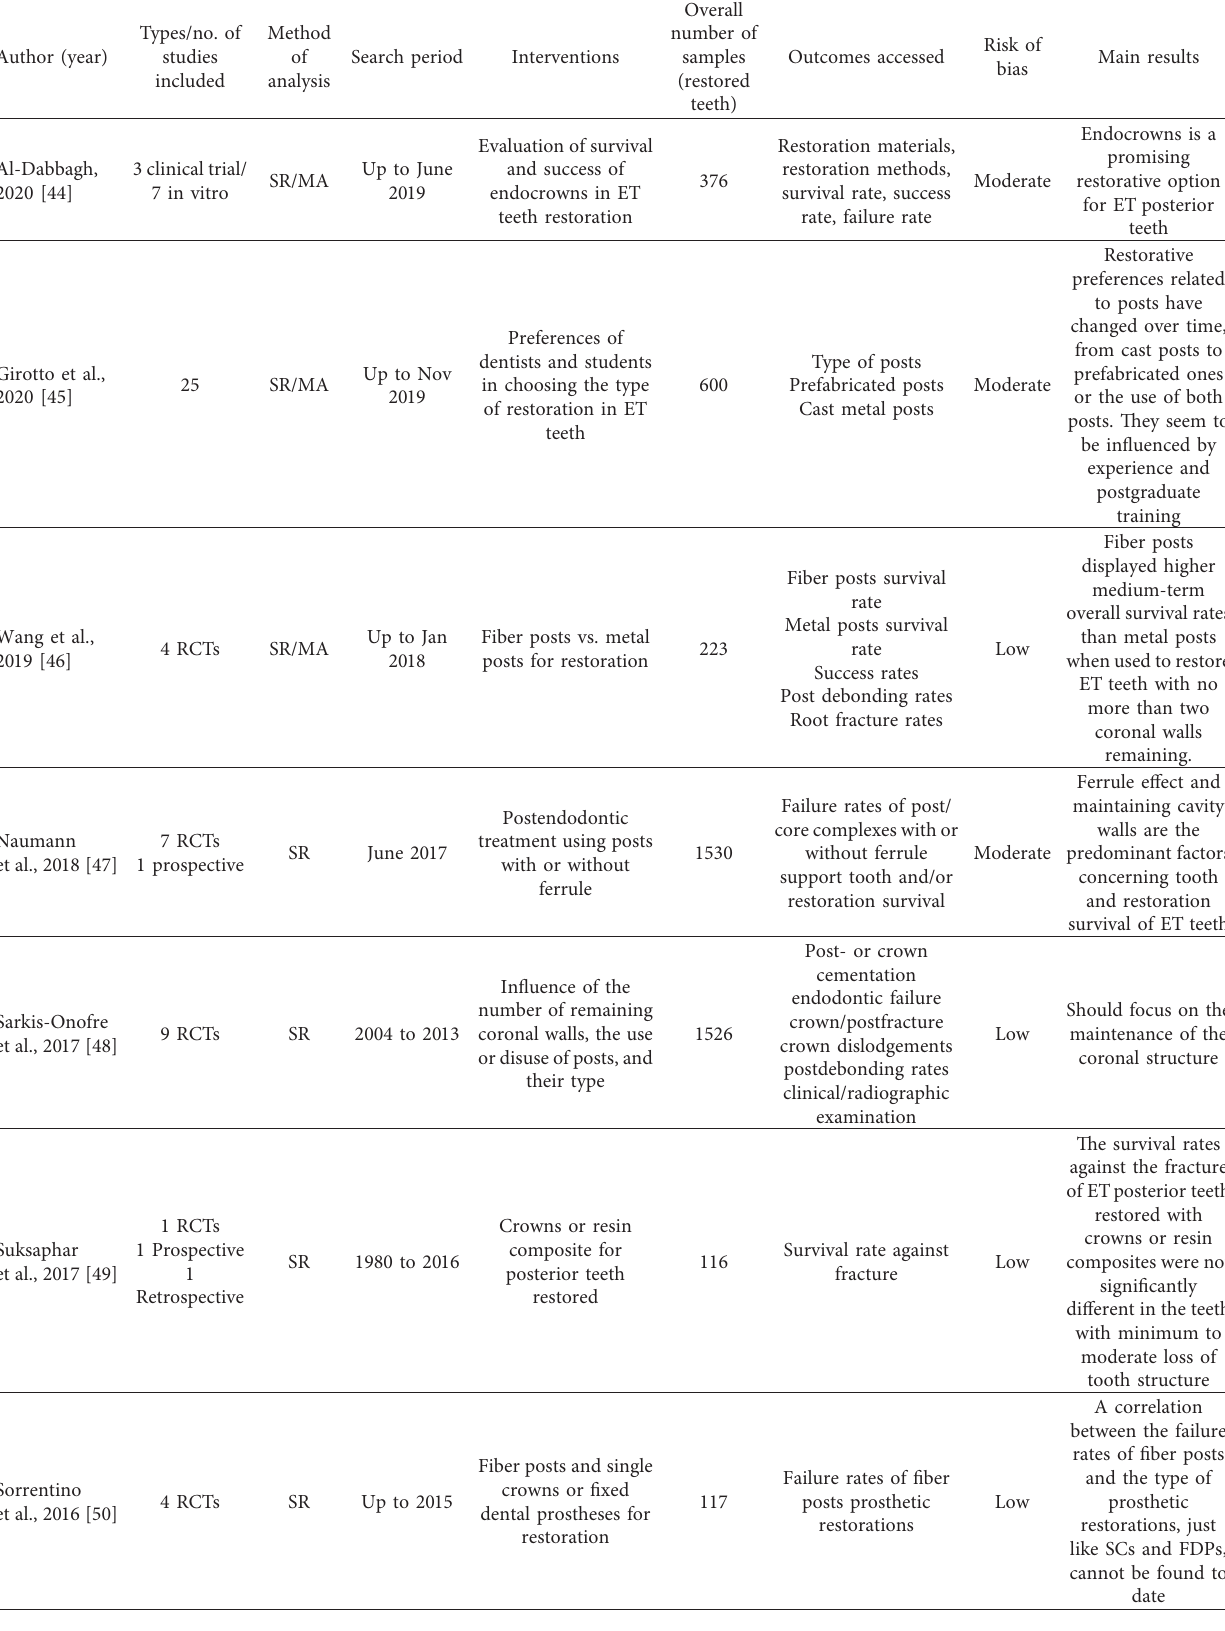
Table 3: Baseline characteristics of systematic reviews assessing the prosthetic restorations on endodontically treated